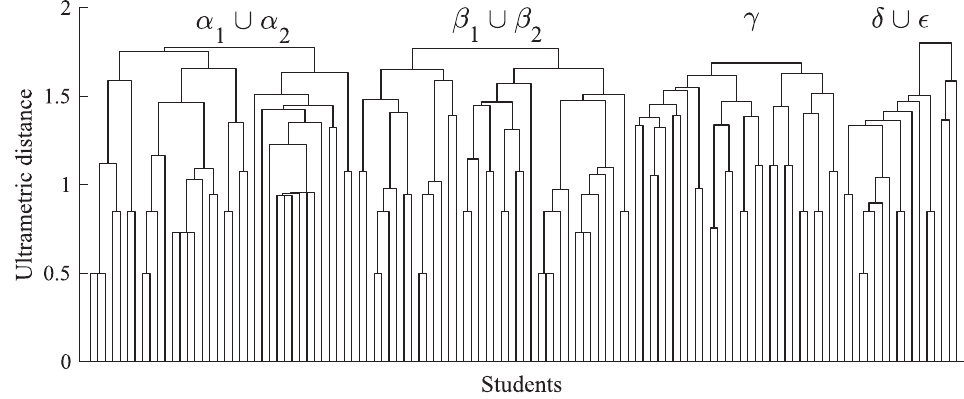
FIG. 11. Dendrogram plot of our sample in which four clusters ( α 1 ∪ α 2 , β 1 ∪ β 2 , γ , δ ∪ ε ) are clearly highlighted.